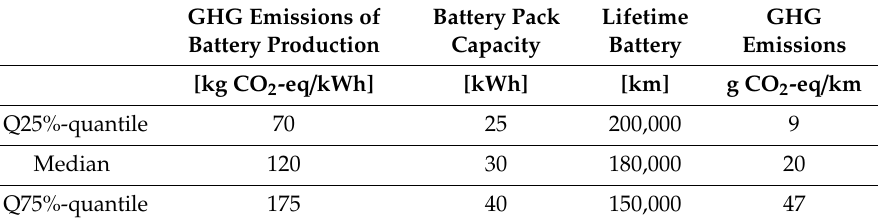
Table 3. GHG emissions [g CO 2 -eq / km] contributed by battery production to drive one km. GHG Emissions of Battery